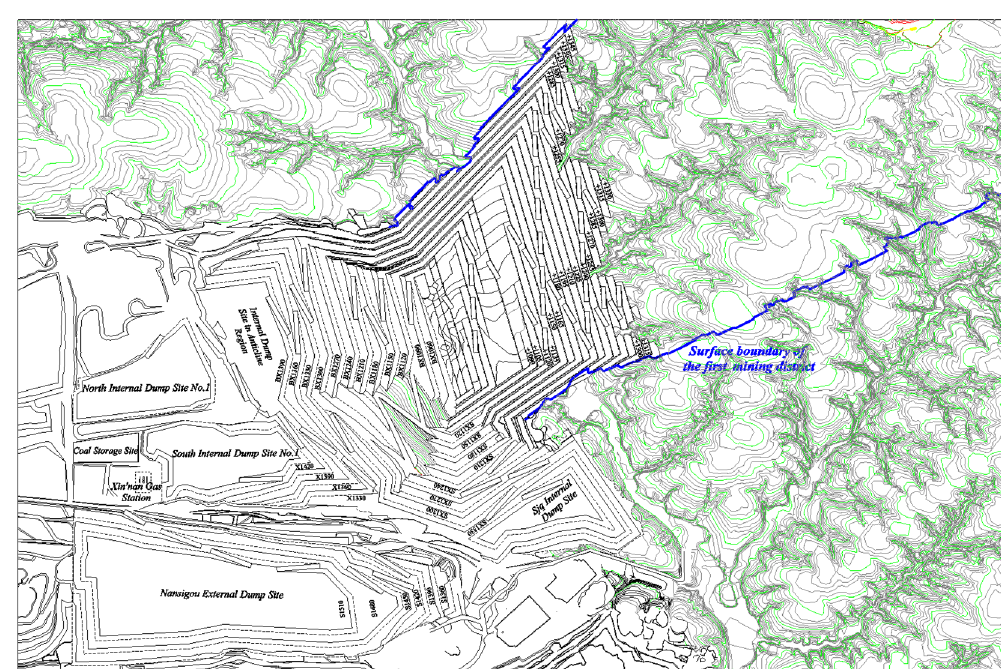
Fig. 18 Plane drawings of mining and dumping plan of pseudo-longitudinal mining scheme in anticline